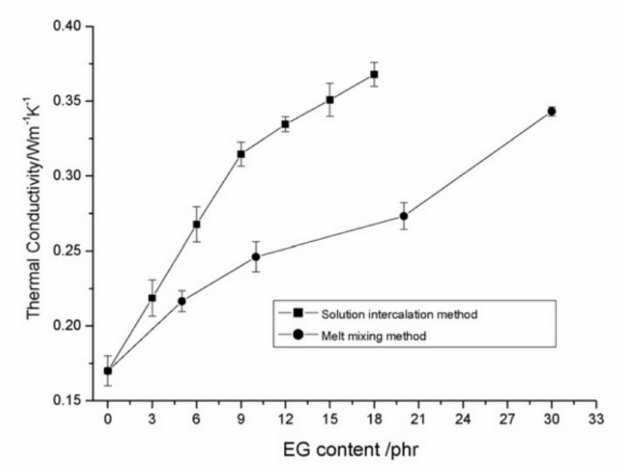
Figure 3. Thermal conductivity vs. fraction of EG for silicone rubber/EG composites prepared by different methods [147]. Copyright © 2021 Elsevier B.V. All rights reserved.